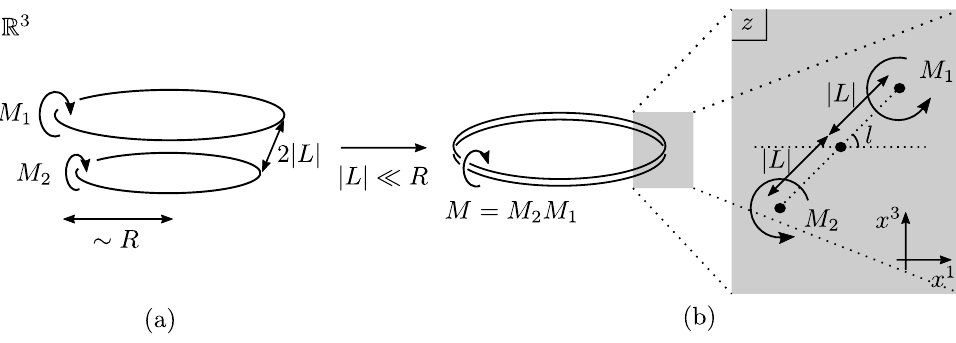
Figure 2 . (a) A con(cid:12)guration of two circular supertubes sharing the axis. (b) The con(cid:12)guration in the colliding limit, j L j (cid:28) R . In this limit, we can study the problem in two di(cid:11)erent regimes, the near and far regions. In the near region, the system becomes 2-dimensional but we must consider two separate monodromies M 1 ; M 2 of two supertubes. In the far region, the system remains 3- dimensional but there is only one tube with monodromy M = M 2 M 1